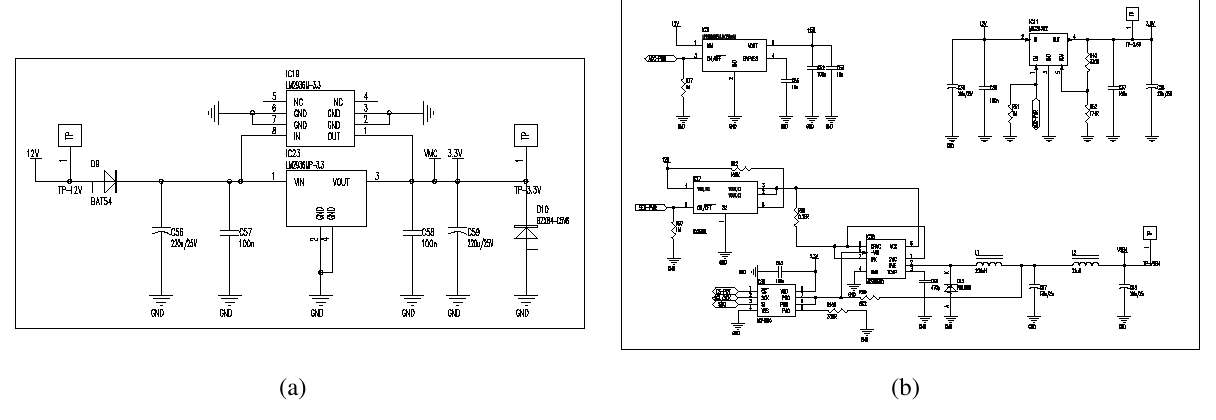
Figure 7. Circuit schematic of the power supply module. ( a ) Power supply for GPRS, sensors, and ADC converter, ( b ) power supply for